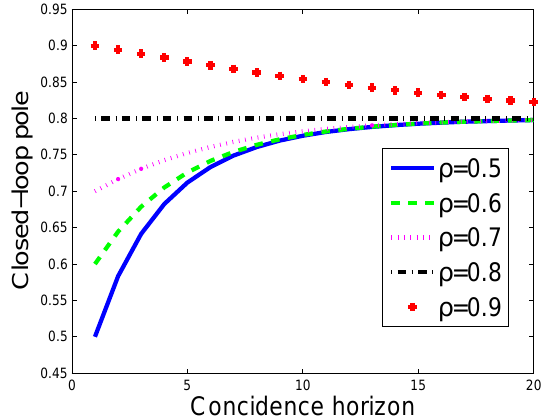
Figure 3. Closed-loop pole dependence upon coincidence horizon and (cid:26) for a = 0 : 8